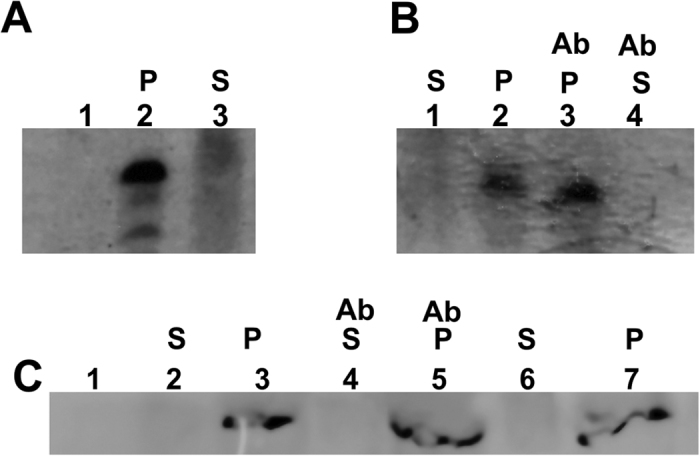
Autoradiograph of cytochrome b6 expressed in cell-free assay in the presence of thylakoid membrane and stroma.(A) Lane 1, thylakoid membrane as a control; lanes 2 and 3, translation of cytochrome b6 in the presence of thylakoid membrane and stromal fraction, supernatant (S) and membrane pellet (P) after fractionation; (B) Lanes 1 and 2 translation of cytochrome b6 in the presence of thylakoid membrane and stromal fraction, supernatant (S) and membrane pellet (P) after fractionation; lane 3 and 4, translation of cytochrome b6 in the presence of thylakoid membrane, stroma and cpSecY antibody, membrane pellet (P) and supernatant after fractionation; (C) Lane 1, thylakoid membrane as a control; lane 2 and 3, translation of cytochrome b6 in the presence of thylakoid membrane and stromal fraction, supernatant (S) and membrane pellet (P) after fractionation, lane 4 and 5, translation of cytochrome b6 in the presence of thylakoid membrane, stroma and cpSecY antibody, membrane pellet (P) and supernatant (S) after fractionation; lane 6 and 7 same as in lane 2 and 3 but endogenous RNA in stroma was removed by enzymatic digestion before use in translation reaction (reaction were performed in the presence of RNasin ribonuclease inhibitor).